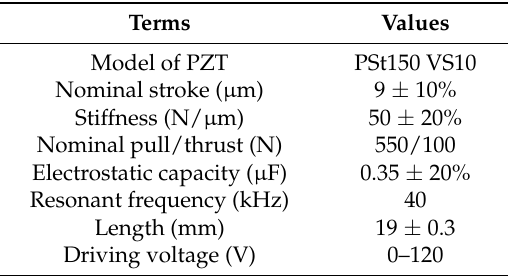
Table 3. The parameters of the piezoelectric (PZT) actuator.